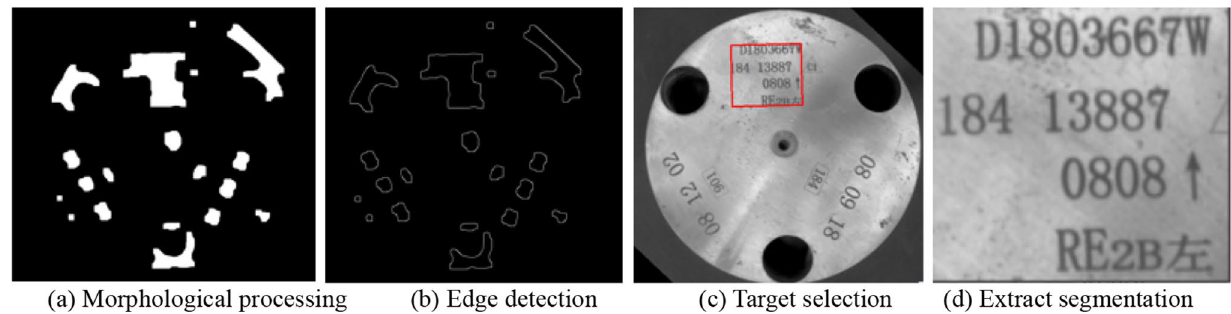
Fig. 14 Morphological